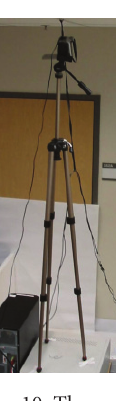
Figure 10: The experimental setup.